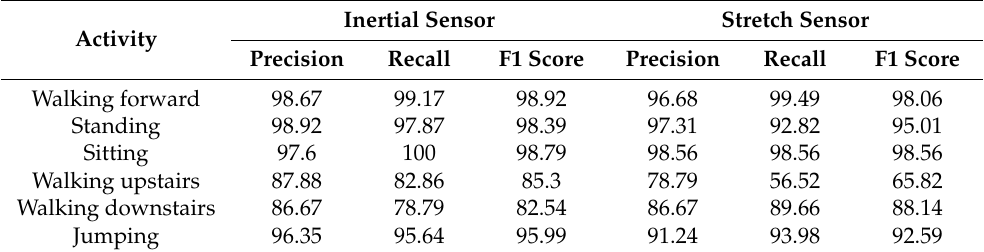
Table 4. The recognition precision, recall, and F1 score for various activities in the W-HAR dataset